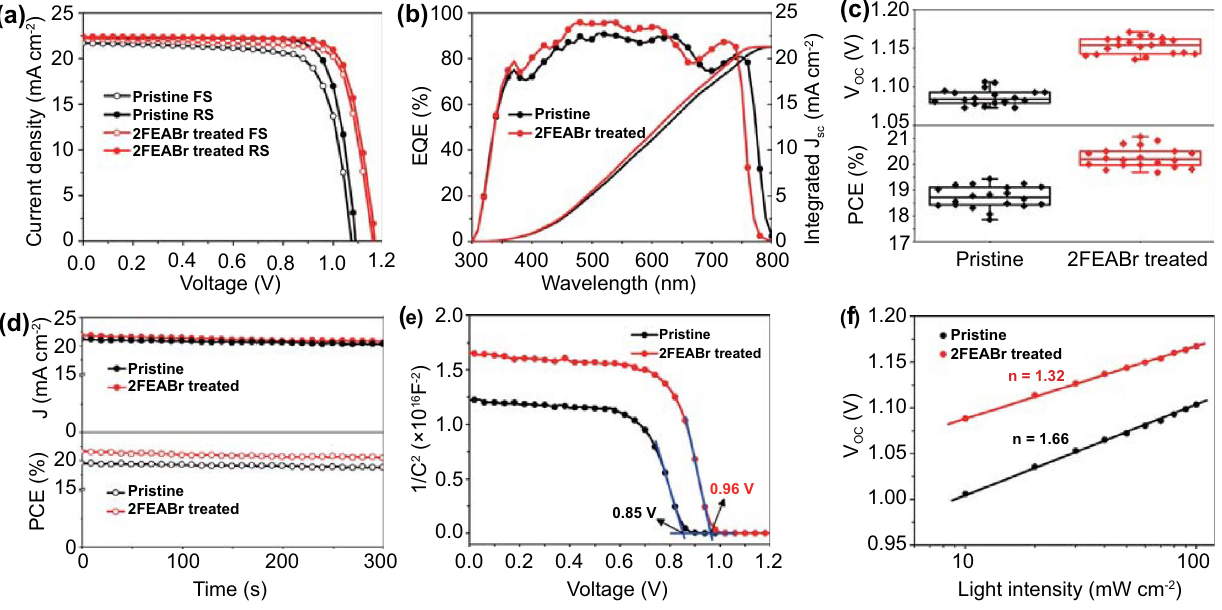
Fig. 3 a J-V characteristics of PSC devices under forward and reverse scans. b EQE spectra with integrated photocurrent. c Statistics of V oc and PCE. d Steady-state photocurrent and power output at the maximal power point. e Mott-Schottky plots. f Dependence of V oc on light